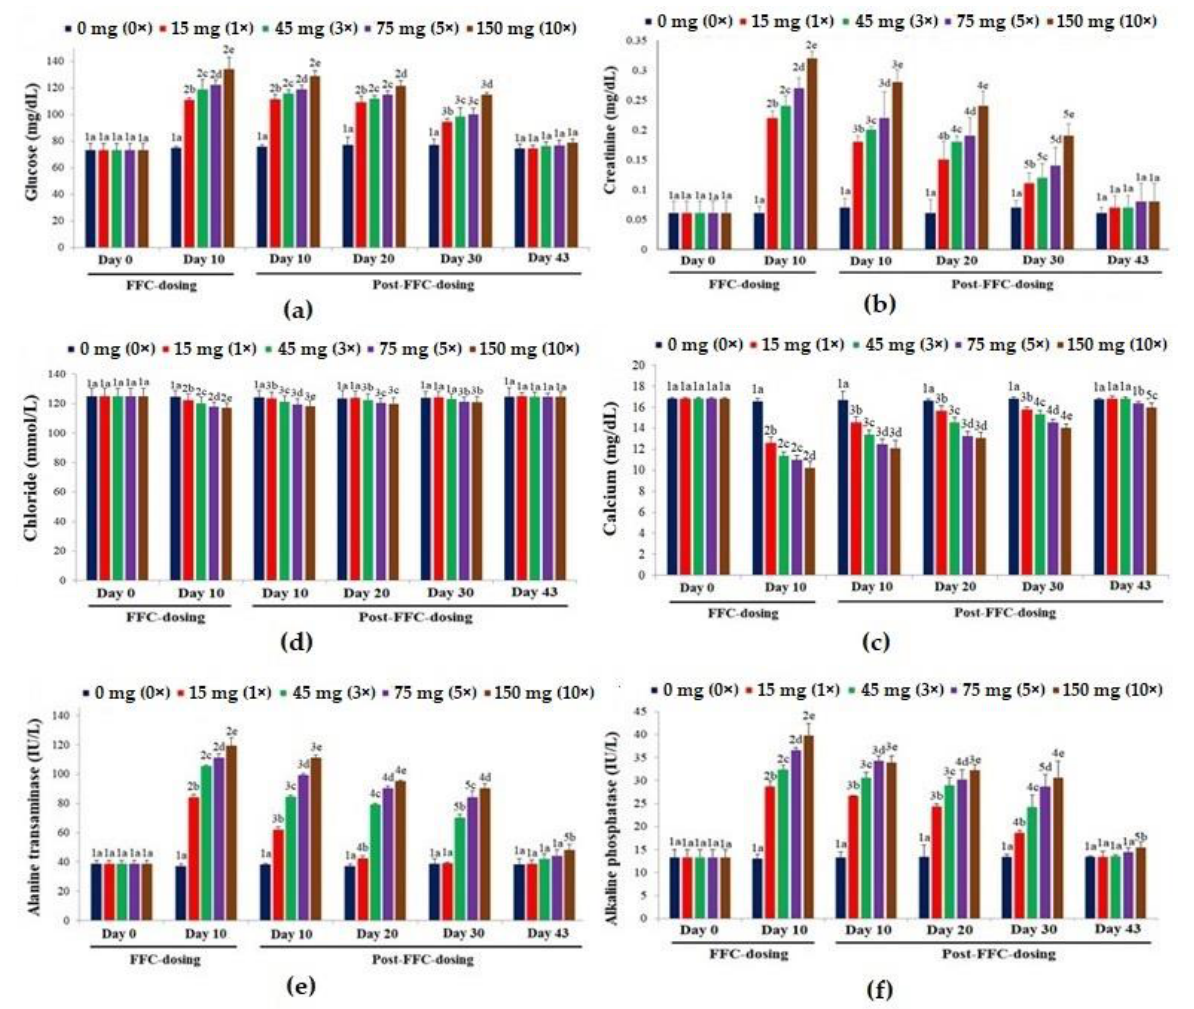
Figure 5. The effects of dietary florfenicol (FFC) administration at 1 – 10 times the therapeutic dose of 15 mg kg biomass − 1 day − 1 for 10 consecutive days on the serum ( a ) glucose, ( b ) creatinine, ( c ) calcium, ( d ) chloride, ( e ) alanine transaminase [ALT] and ( f ) alkaline phosphatase [ALP] levels of Oreochromis niloticus juveniles. a–e: Bars of a particular day showing common alphabets differed insignificantly ( p > 0.05). 1–5: Bars of a particular treatment (dose) showing common numerals differed insignificantly ( p > 0.05). Table 2. The histoarchitectural changes in Oreochromis niloticus juveniles upon dietary FFC